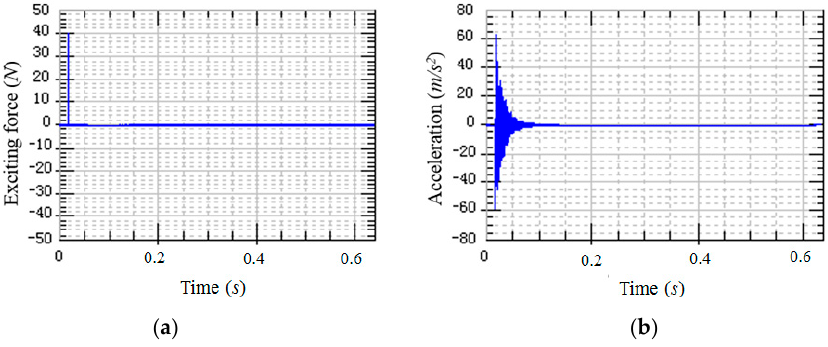
Figure 4. An example of modal test signal. ( a ) Stimulus signal; ( b ) response signal.